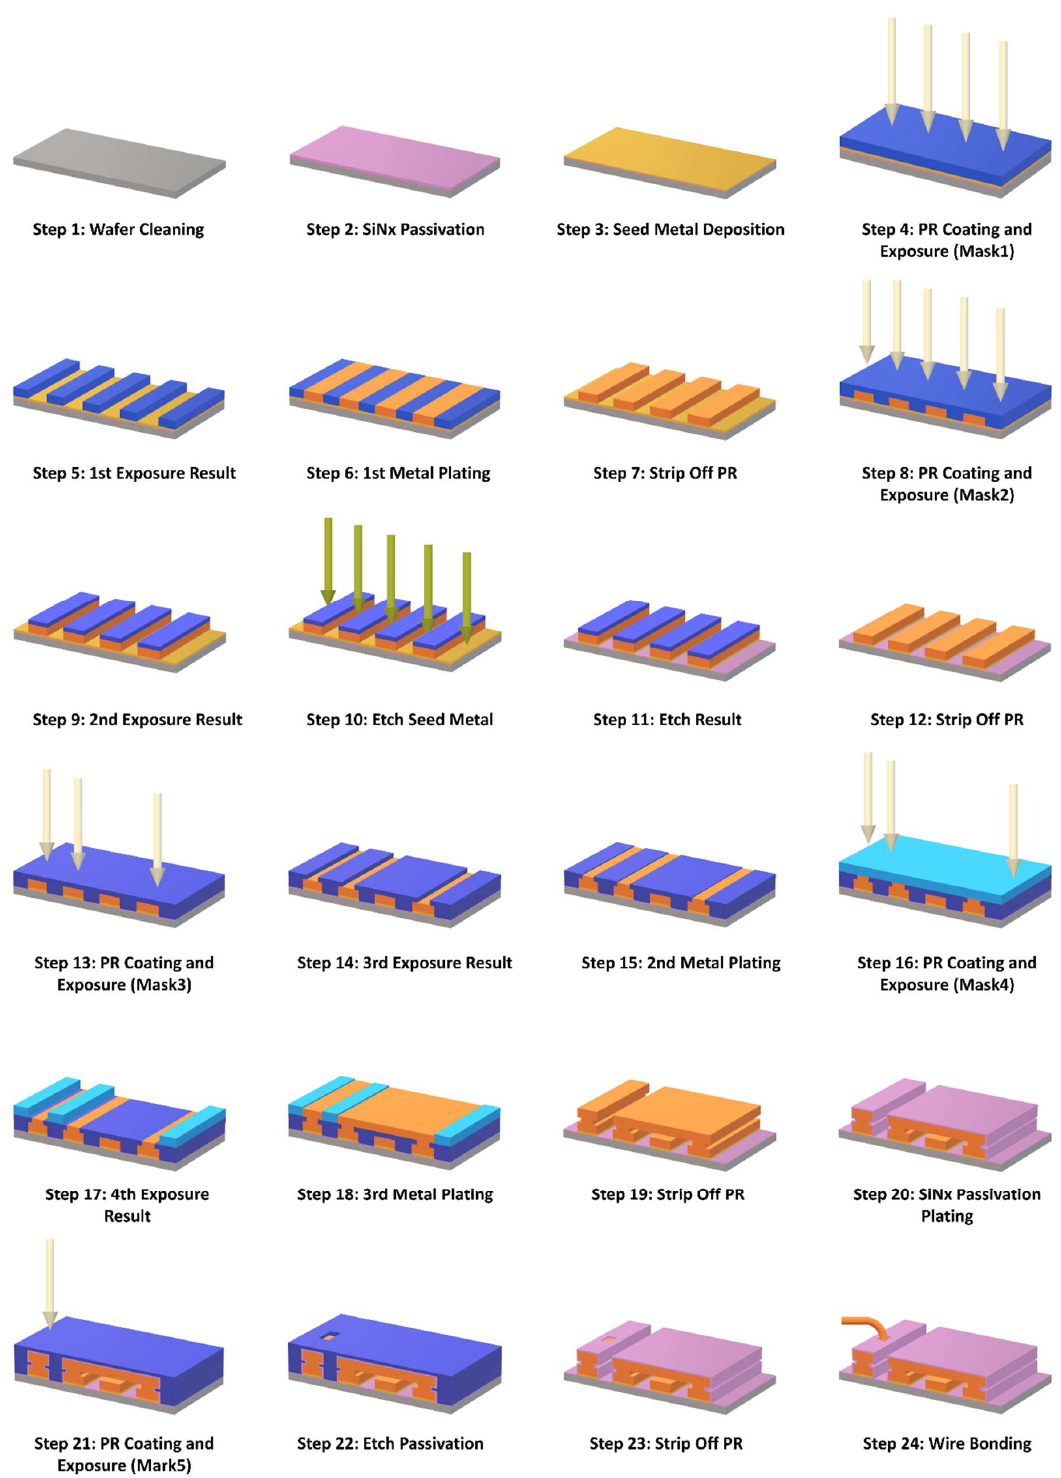
Figure 5. GaAs-based integrated passive device (IPD) technology fabrication flow.